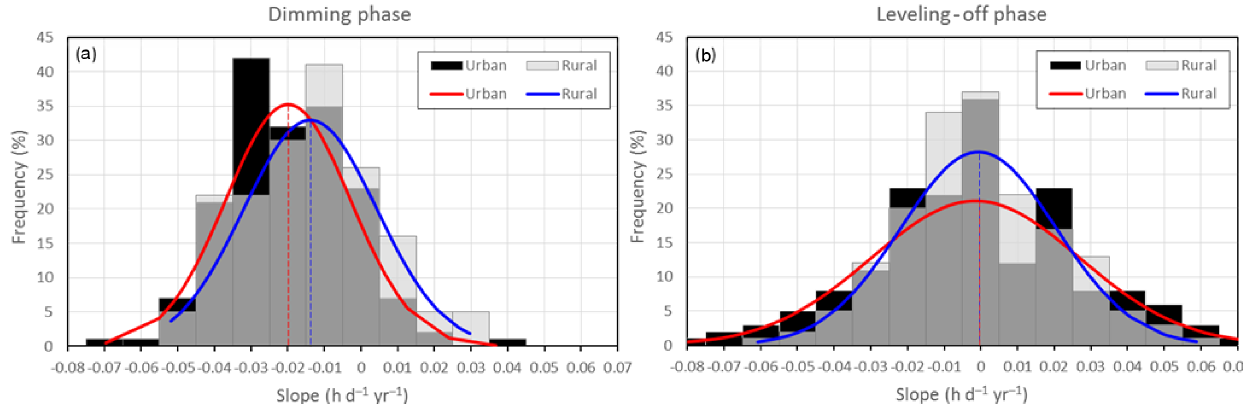
Figure 3. Frequency distribution histograms of urban (black bars) and rural (transparent light gray bars) sunshine duration trend slopes (hd − 1 yr − 1 ) for the dimming (1960–1989) and leveling-off (1990–2013) phases. The dark gray parts of the bars are the overlaps of the frequency distributions for urban and rural trend slopes. The red and blue solid lines are the expected normal distribution of the trend slopes for urban and rural stations, respectively, while the dashed lines indicate the means.